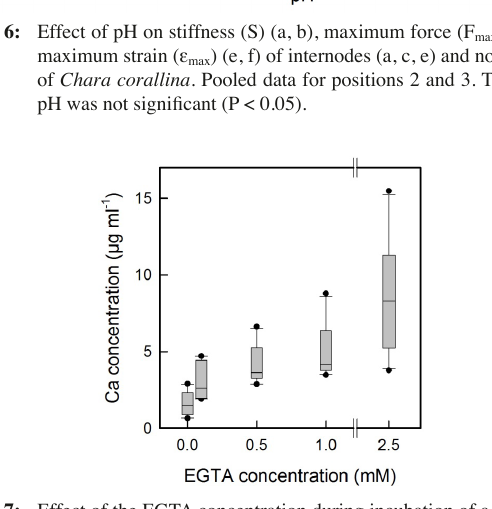
Fig. 7: Effect of the EGTA concentration during incubation of a single node and internode taken from positions 2 and 3 on the amount of Ca re- leased.